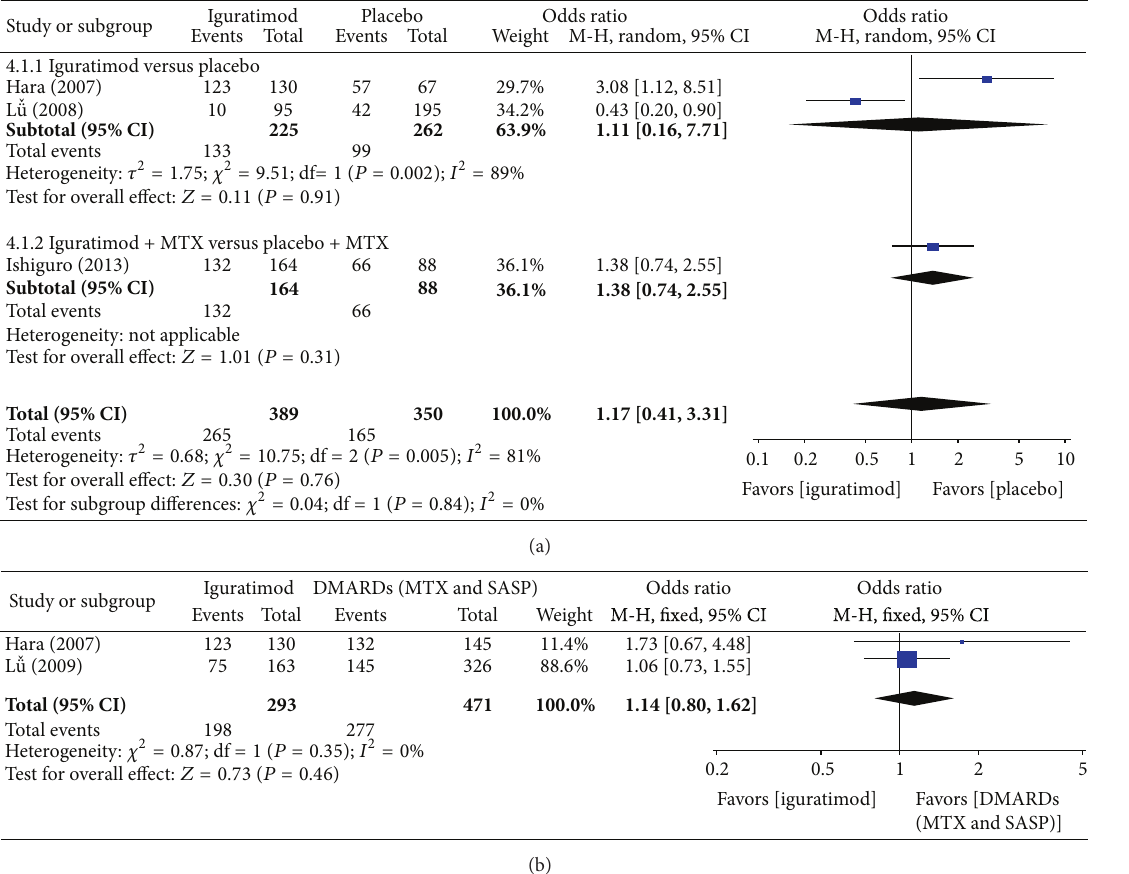
Figure 13: (a) Comparison of adverse events between iguratimod and placebo groups. (b) Comparison of adverse events between iguratimod and other DMARDs (MTX and SASP)